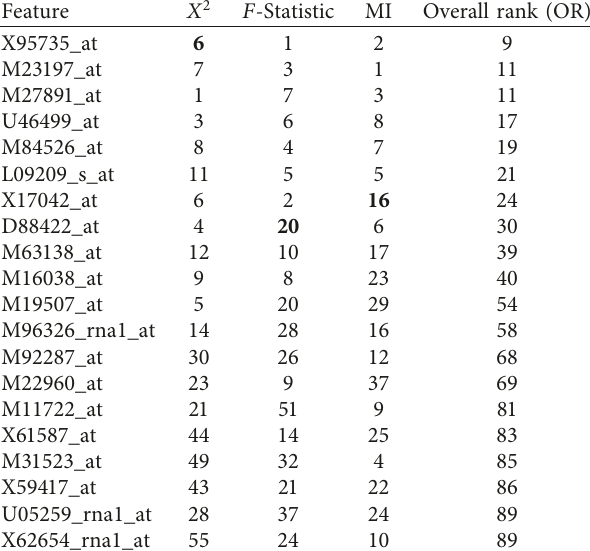
Table 7: Overall rank table (ORT) for the ovarian cancer dataset. Features are arranged from the most important, at the top, to the least important at the bottom according to their assigned overall rank (OR), which is calculated after moderating the outliers (shown in bold) as per Algorithm 1. The smaller the overall rank, the more significant the